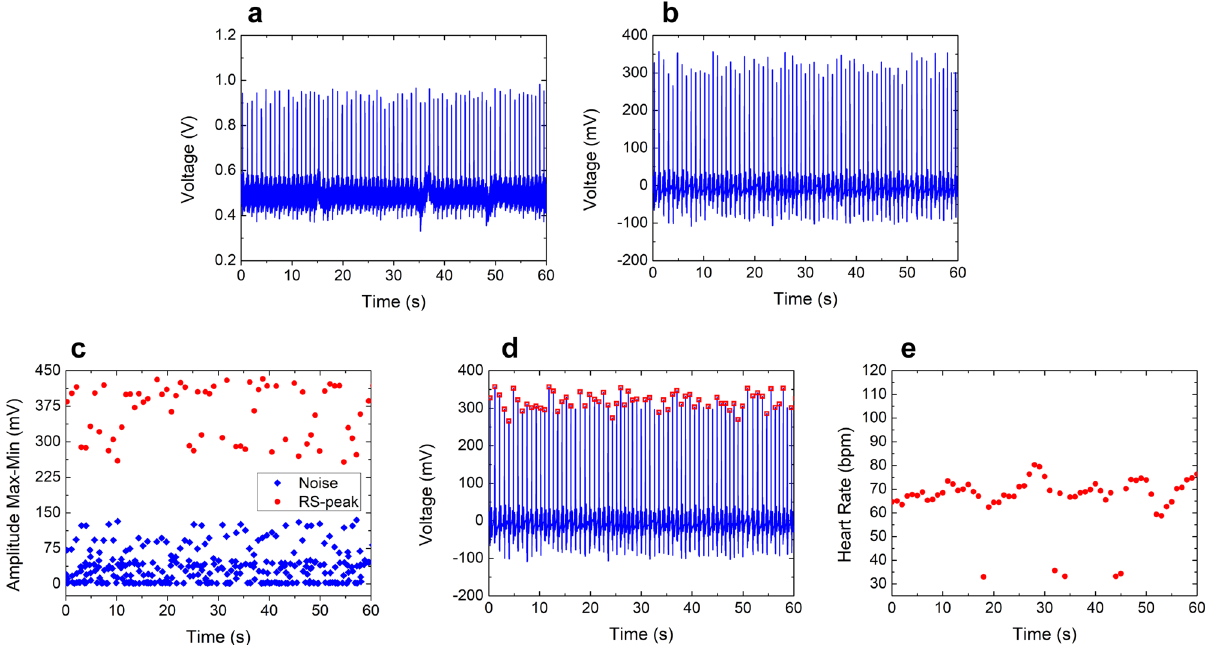
Fig. 3 Electrodes performance in electrocardiography and heart rate monitoring. a Raw ECG signal recording with some motion artifacts performed with the LINA-based electrodes. b Resulting signal after the baseline correction and noise suppression using the proposed DWT- based method. c Two-cluster classi fi cation (RS-peaks and noise) of the peaks which compose the ECG signal. d Identi fi cation of the RS-peaks along the 60 s signal from the clustering algorithm results. e Evolution of the heart rate over time extracted from the RS-peaks